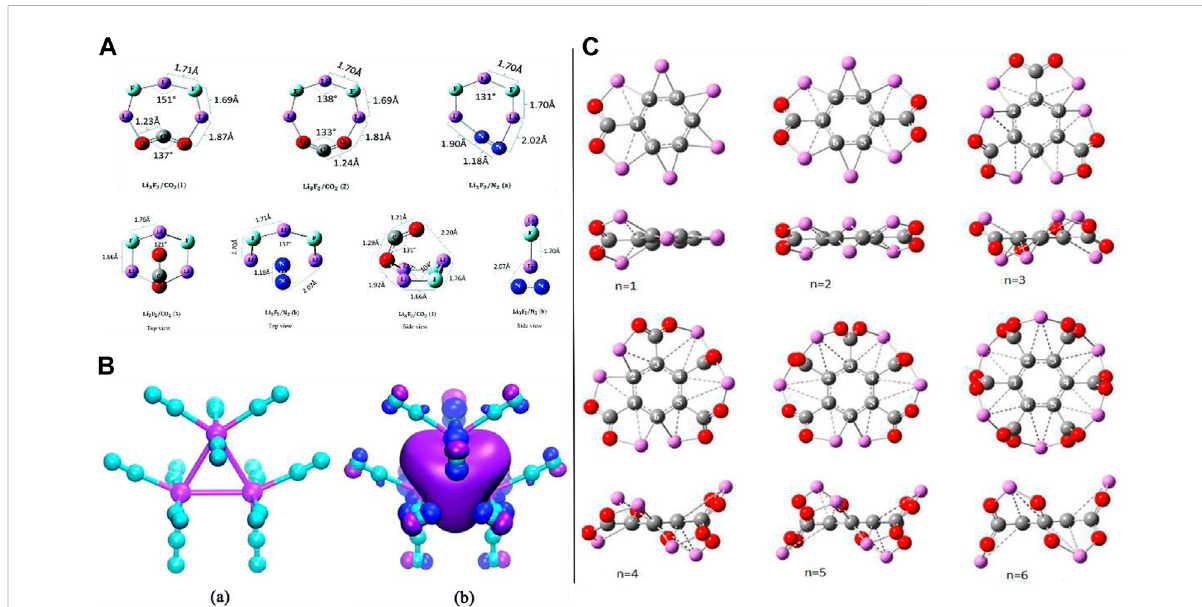
FIGURE 4 (A) Optimized geometries of neutral planar clusters (top) and neutral non-planar clusters (bottom) adapted from Park and Meloni (2017) with permission from the Royal Society of Chemistry; (B) (a) optimized structure of the Li 3 + (N 2 ) 12 complex and (b) its HOMO 3D isosurface map adapted from Yu et al. (2020) with permission from the Royal Society of Chemistry; (C) optimized structures of C 6 Li 6 – nCO 2 complexes(front and side views) for n = 1 – 6 adopted from Srivastava (2019b) with the permission of